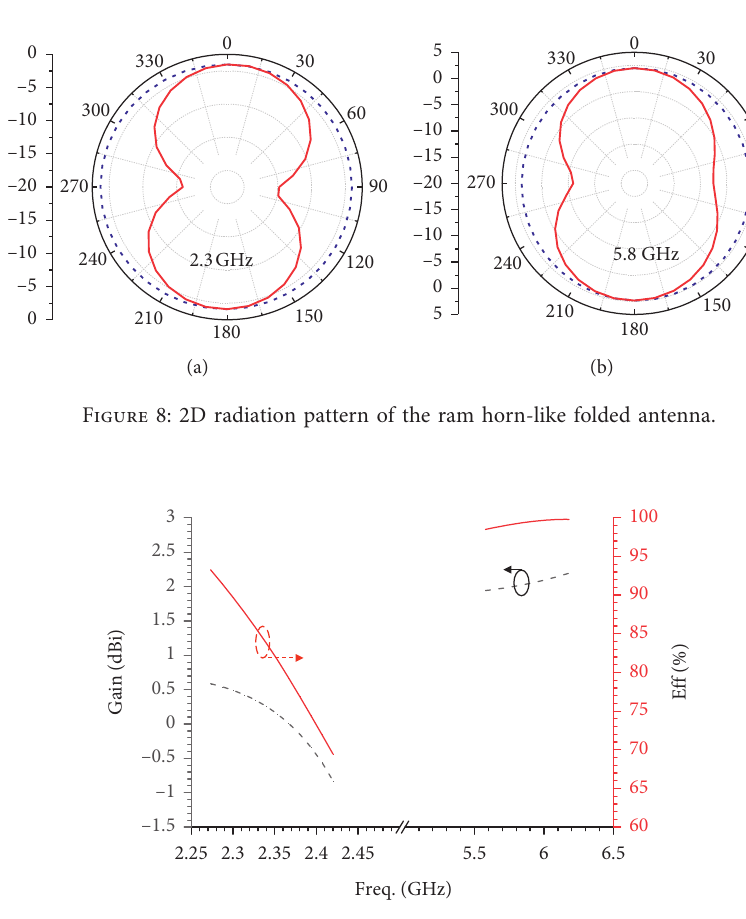
Figure 9: Gain and efficiency of the ram horn-like folded antenna proposed.